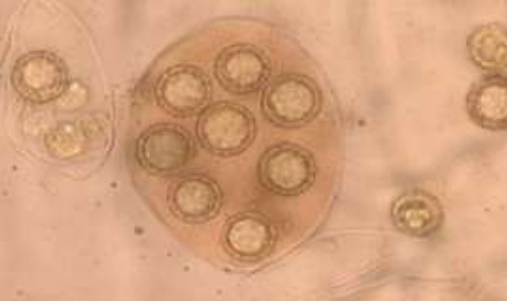
Figure 3. An ascus of Terfezia claveryi which contains 8 globose spores ornamented with warts (colored with alcoholic iodine, magnification ×40).